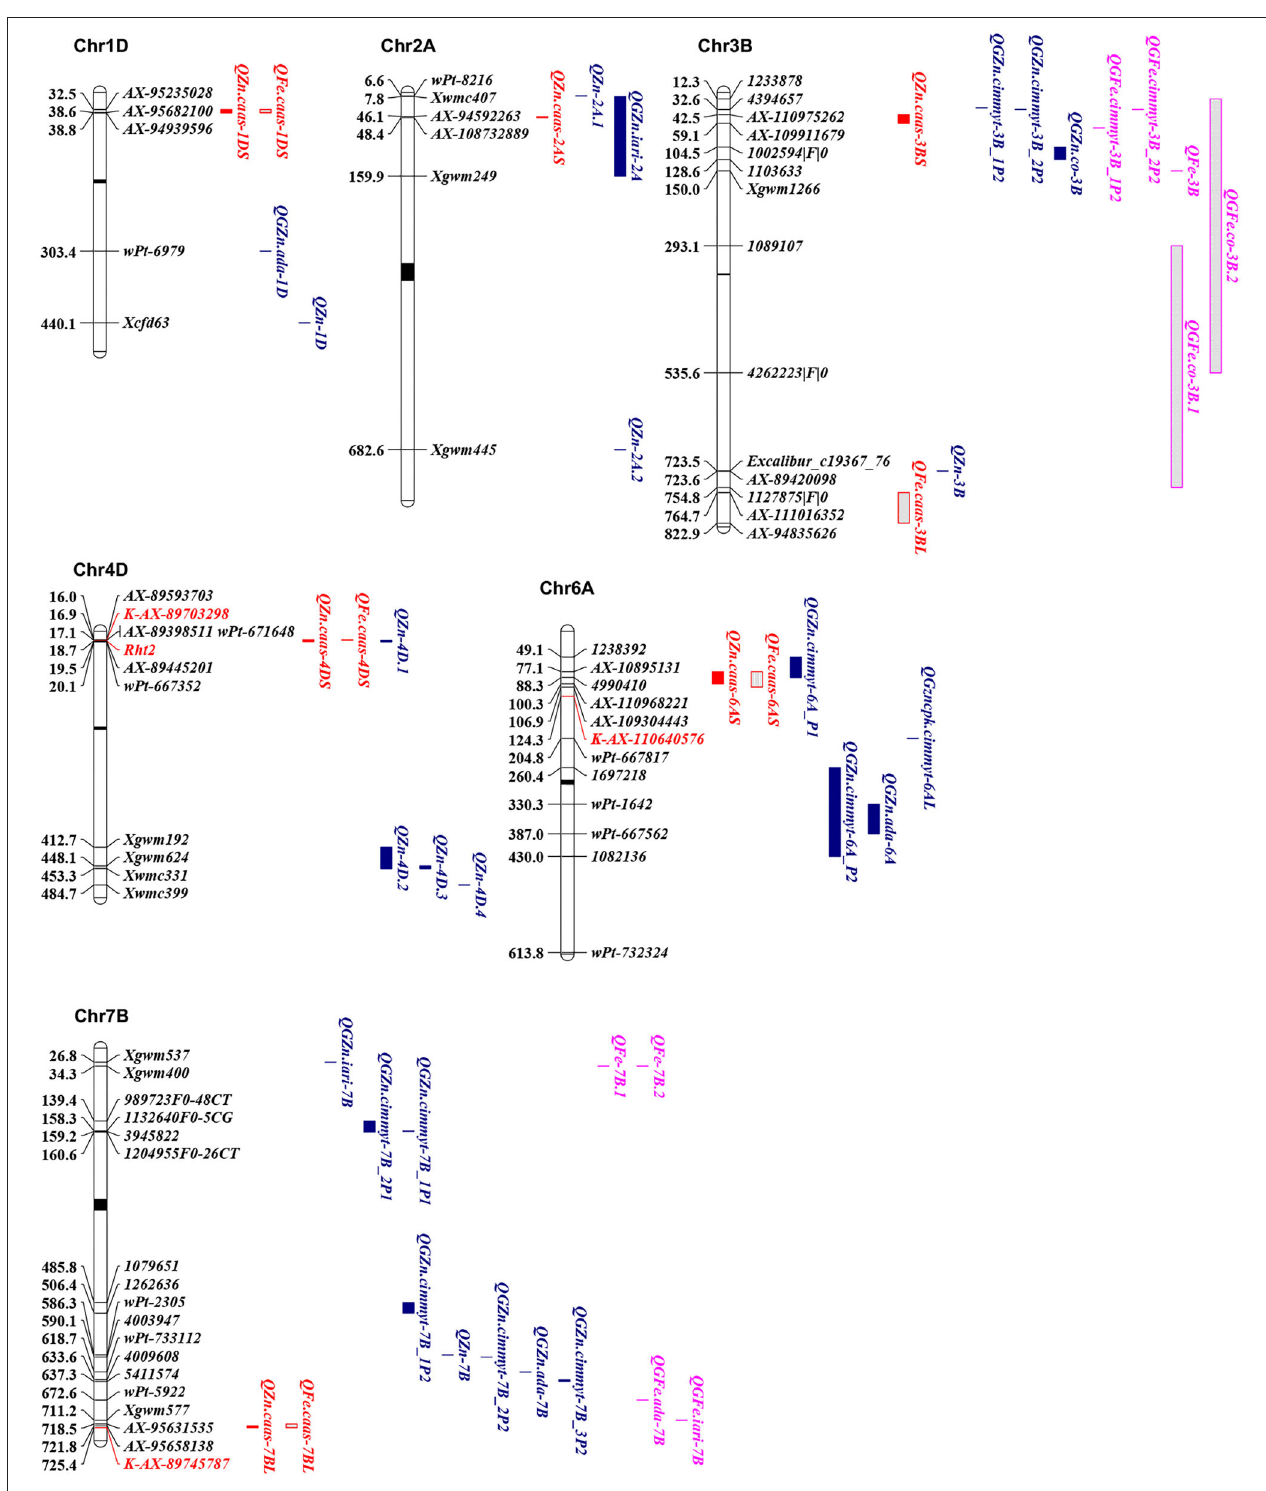
FIGURE 3 | Physical maps for the positional comparisons of GZn and GFe QTL reported on chromosomes 1DS, 2AS, 3BL, 4DS, 6AS, and 7BL with those identified in the present study. QTL linked markers are shown on the right, physical positions are shown on the left, and centromere is shown in the middle (black bar). KASP markers developed in the present study were shown in red. QTL for GZn and GFe in the present study were in red; QTL for GZn in previous studies were in blue; QTL for GFe in previous studies were in purple.